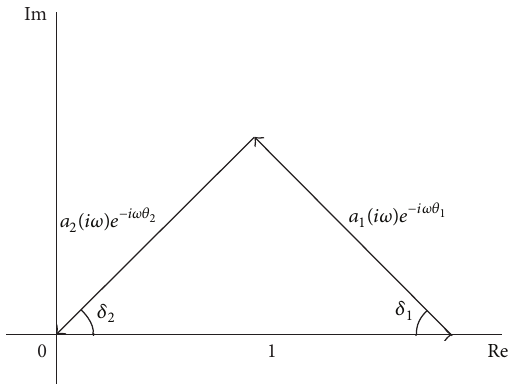
Figure4:Triangleformedby 1 , |𝑎 1 (𝑖𝜔)| ,and |𝑎 2 (𝑖𝜔)| onthecomplex